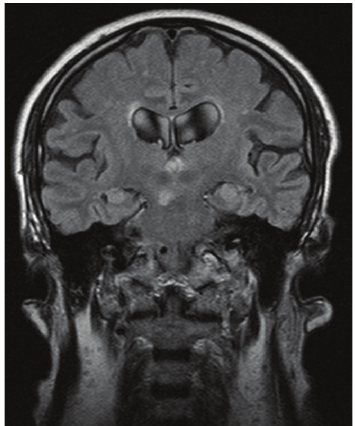
Figure 3: MRI Flair—ischemic lesion at the cerebral trunk evolving the right median